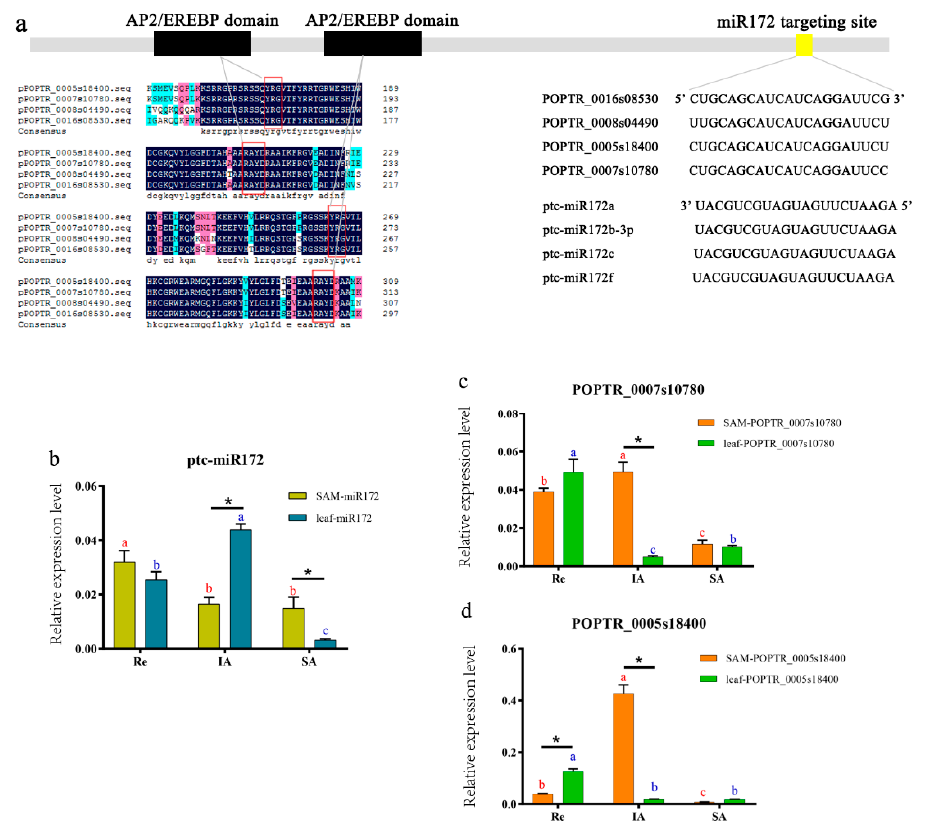
Figure 6. miR172 and its targets. ( a ) Conserved regions and miR172 target sites within P. tomentosa AP2 transcripts; red boxes represent two conserved AP2/EREBP domains. ( b – d ) qRT-PCR analysis of the expression levels of miR172 ( b ) and its targets POPTR_0007s10780 ( c ) and POPTR_0005s18400 ( d ). The columns and error bars indicate means and standard deviations ( n = 3), respectively; * indicates significant differences ( p < 0.05) between the shoot apical meristem (SAM) and leaves at each stage; Non-overlapping letters (a–c) indicate significant differences ( p < 0.05) of SAM (red letters: a, b, c) or leaves (blue letters: a, b, c) among three different stages.